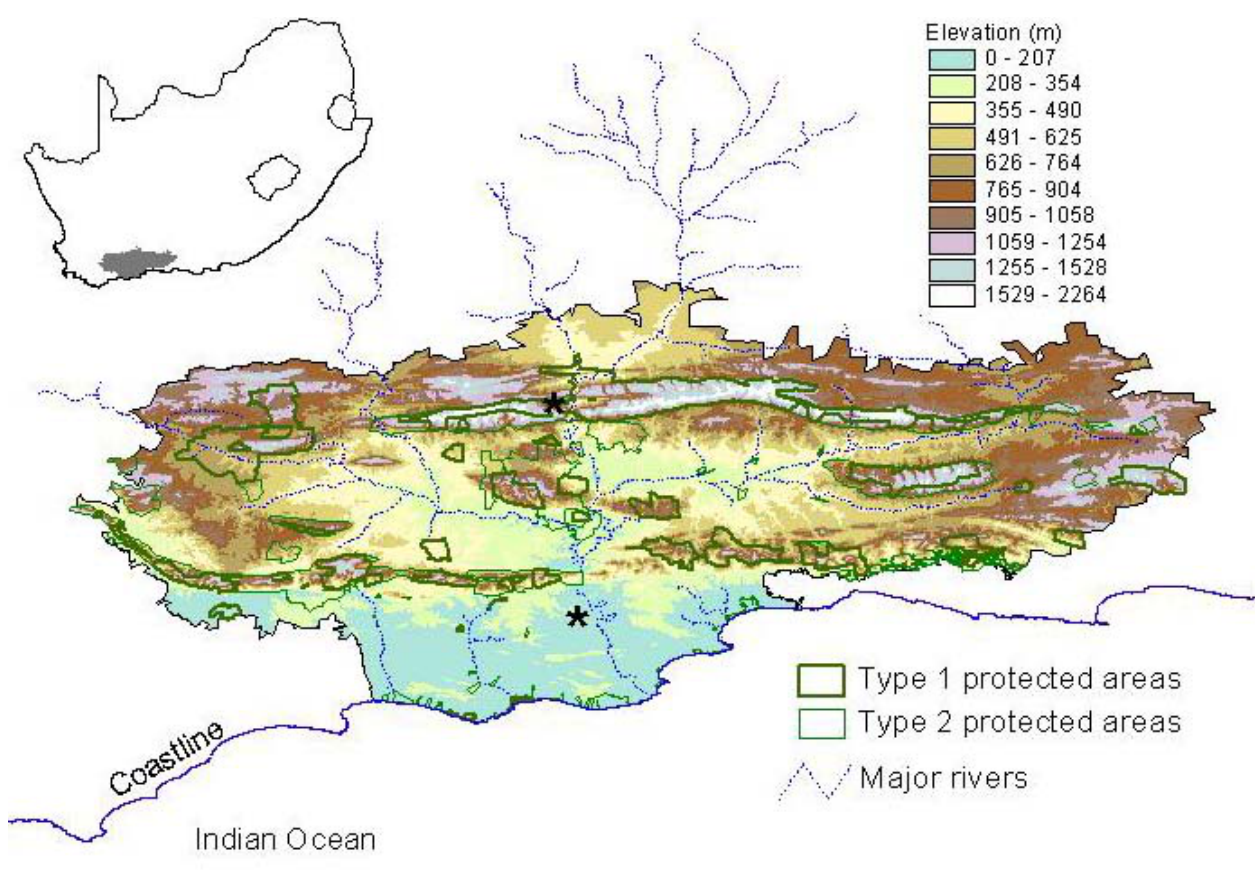
Fig. 2. The location of the Gouritz planning domain in South Africa (inset). The enlarged map shows perennial rivers, and existing protected areas (Types 1 and 2) that lie in two east-west axes mainly along the two mountain ranges. Broadly speaking, the Nama-Karoo biome lies to the north of the northern mountain range, and the fynbos biome lies between the southern mountain range and the sea, as well as on the mountains. The Succulent Karoo biome lies mainly between the two mountain ranges, as thicket vegetation tracks most river courses and coastal areas. The forest biome enters the planning domain only in the